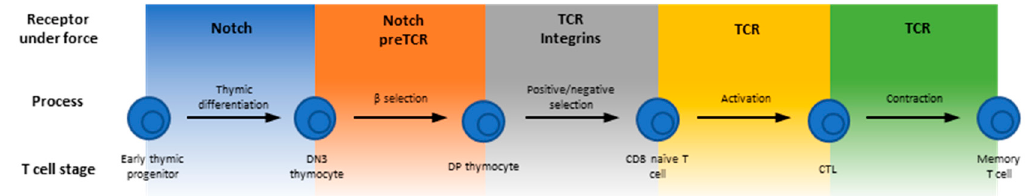
Figure 1. Mechanotransduction occurs throughout the life cycle of T lineage cells. Schematic depicting development of a T lineage cell and instances where receptors on the developing cell have been studied to be subject to forces. Lymphoid progenitor encounters Notch and commits to a T cell lineage in the thymus; at the DN3 stage of thymocyte development, the pre-T cell antigen receptor (TCR) may bind to pMHC under force; at the developmental stage from double positive (DP) to single-positive (SP) thymocytes, migration from cortex to medulla is controlled by force-modulated ligand dissociation of β 1 integrins; the αβ TCR relies on force to discriminate between positive and negative selection ligands; the naïve CD8 + T cell is activated when TCR is triggered by pMHC under force; memory T cells survive the contraction phase in part through TCR signaling.